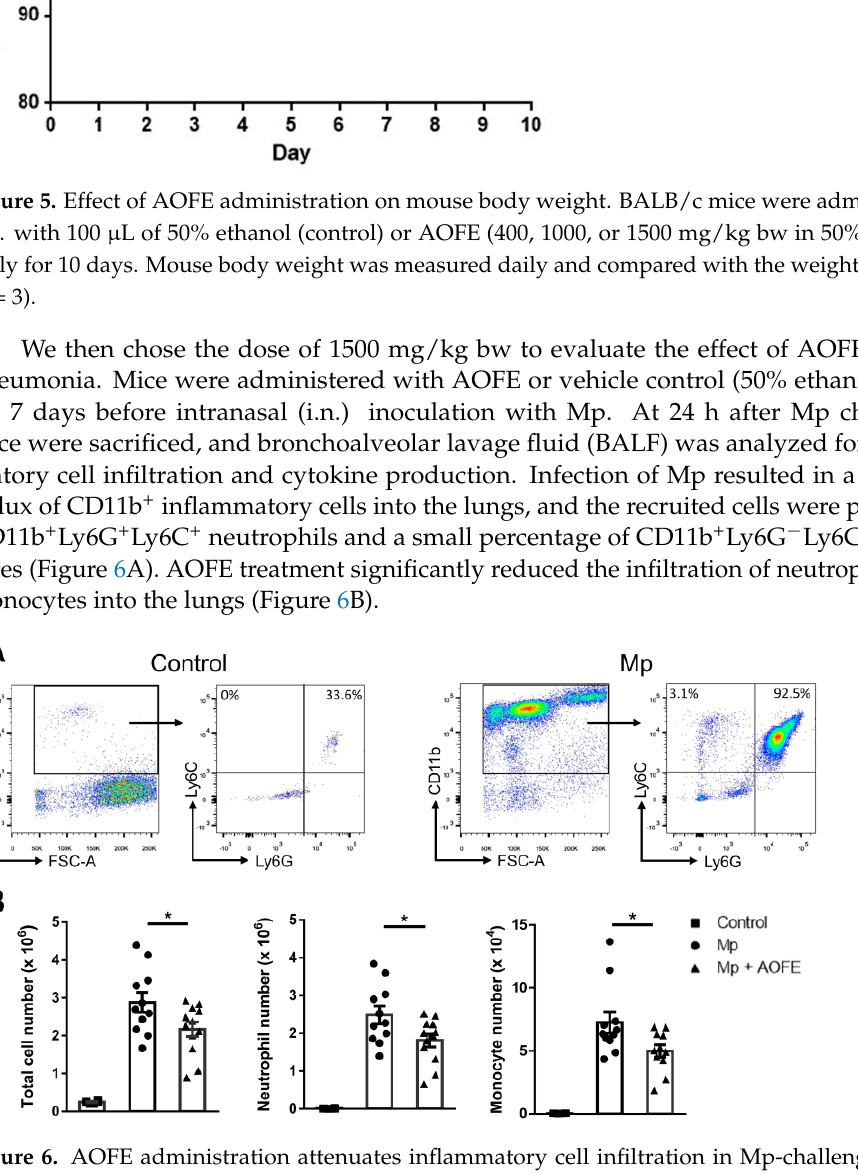
Figure 6. AOFE administration attenuates inflammatory cell infiltration in Mp-challenged mice. BALB/c mice were treated p.o. with vehicle (control and Mp groups) or 1500 mg/kg bw of AOFE (Mp + AOFE group) daily for 7 days before Mp inoculation. Mice in the Mp and Mp + AOFE groups were inoculated i.n. with Mp, and mice in the control group were treated with the vehicle. At 24 h post Mp inoculation, BALF cells were analyzed for surface expression of CD11b, Ly-6C, and Ly-6G by flow cytometry. ( A ) Representative density plots and gating strategies of BALF cells in the control and Mp groups. CD11b + Ly6G + Ly6C + cells represent neutrophils, and CD11b + Ly6G − Ly6C + cells represent monocytes. ( B ) Neutrophil and monocyte numbers in BALF were determined by multiplying the total cell numbers by the percentage of each cell population. The data shown are combined from 3 independent experiments. * p <